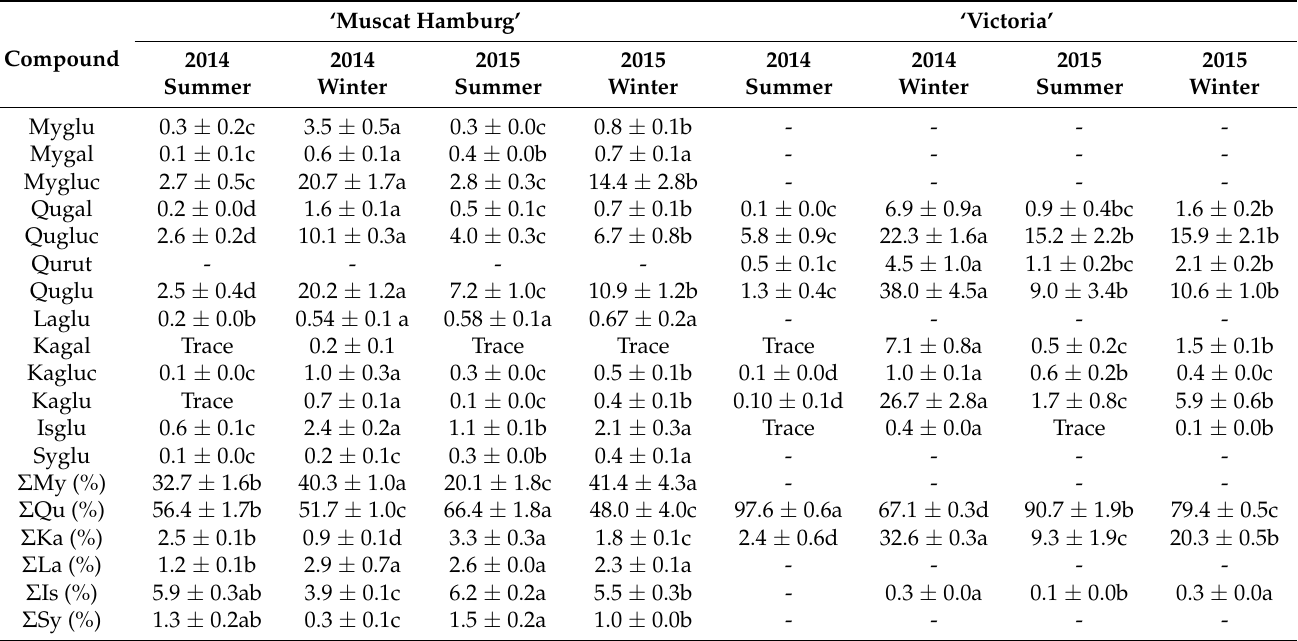
the four seasons in the two varieties. Table 3. Flavonol concentration (mg/kg FW) in ‘Muscat Hamburg’ and ‘Victoria’ grapes in 2014 and 2015 under the double cropping system.